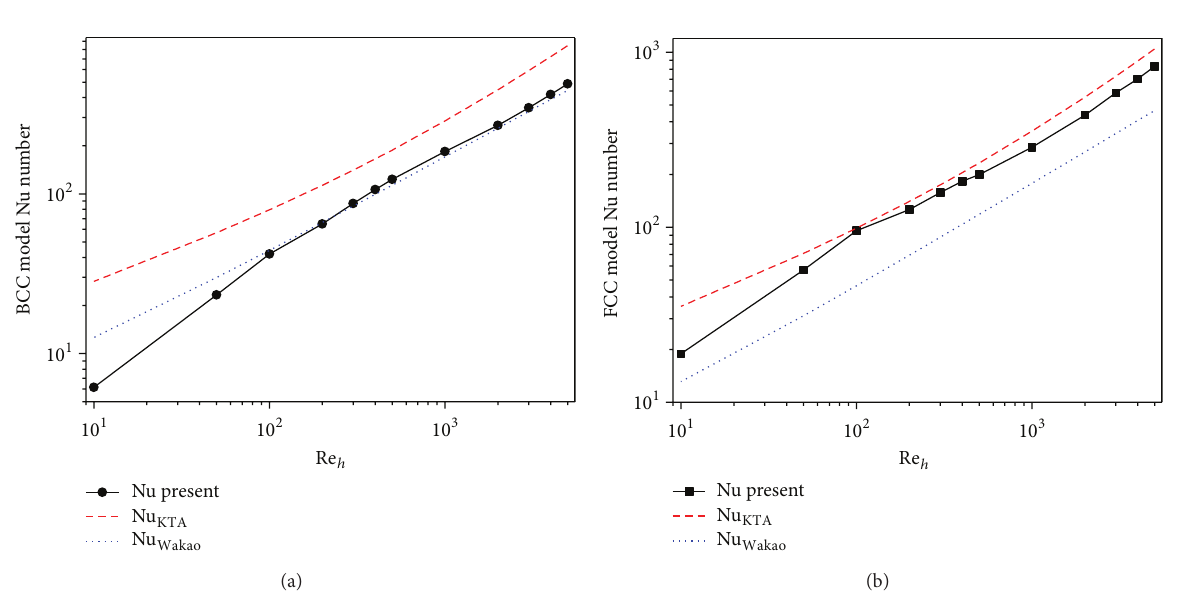
Figure 6: Nu number of BCC and FCC